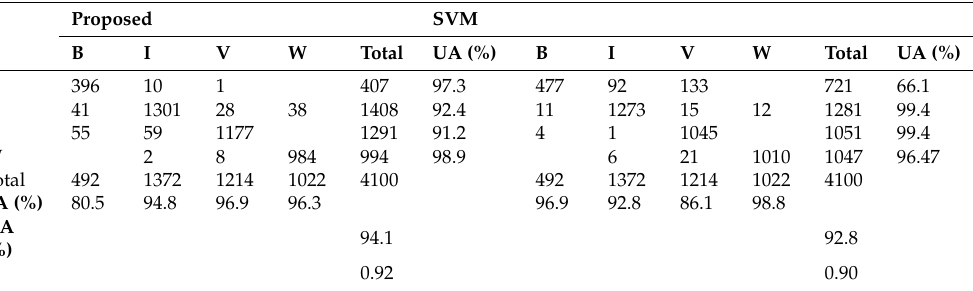
Table 8. Accuracy of results for the Dhaka